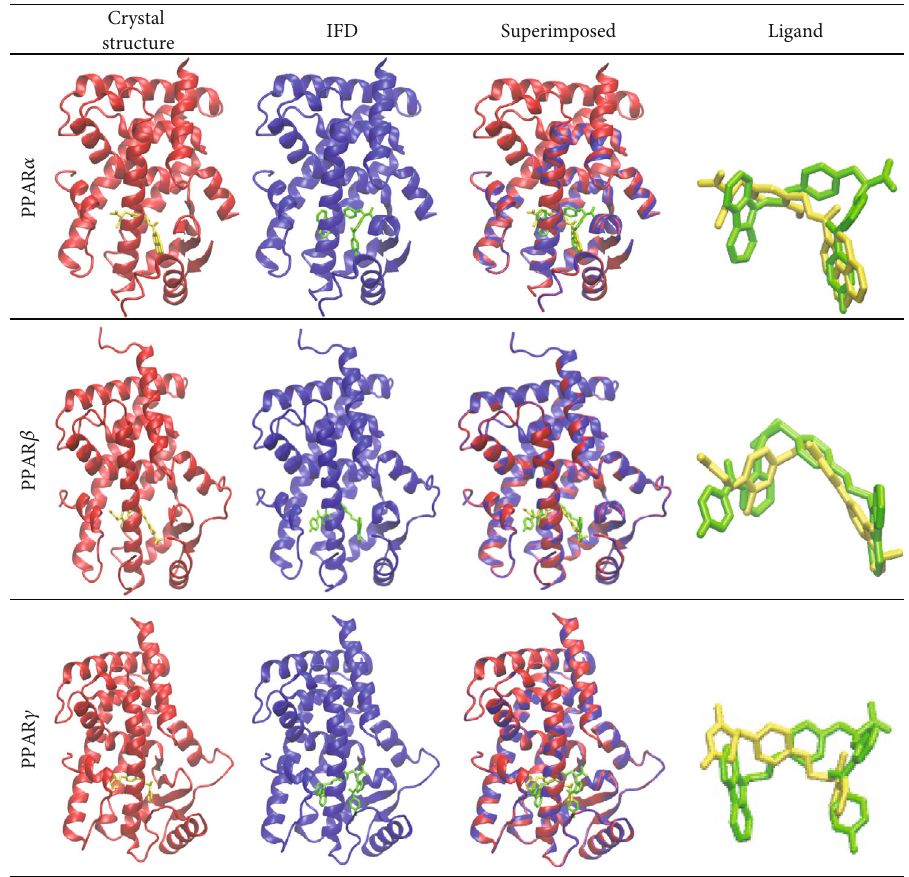
Figure 3: Structure comparison between the crystal complex and the induced fi t docking of chiglitazar to PPAR α with a partial agonist APHM13 (PDB ID: 3VI8), PPAR β with a partial agonist GW0742 (PDB ID: 3TKM), and PPAR γ with a full agonist rosiglitazone (PDB ID: 2PRG). Chiglitazar is shown in green, whereas each crystal ligand is shown in